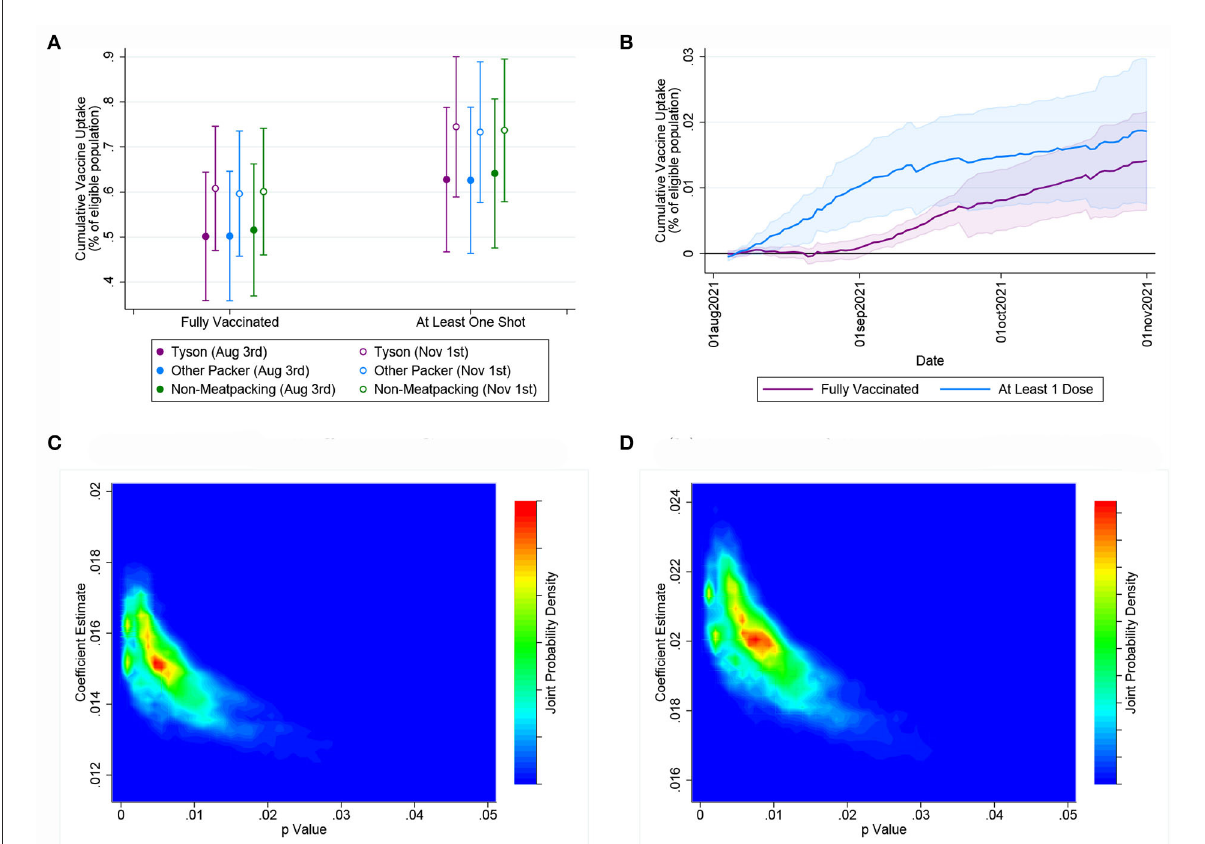
FIGURE2 Impacts of Tyson Food’s employee mandate on county-level vaccine uptake. Figure summarizes the impacts of Tyson Food’s employee vaccine mandate on county-level vaccination rates. (A) reports the results of a difference-in-difference comparison between Tyson, other meatpacking, and non-meatpacking counties evaluated on the date the mandate was announced (August 3, 2021) and at of the mandate deadline (November 1, 2021). (B) of the Figure summarizes the impacts of the mandate on vaccine uptake over time. (C,D) investigate the robustness of our main results using a topographic regression model (Saitone et al.,